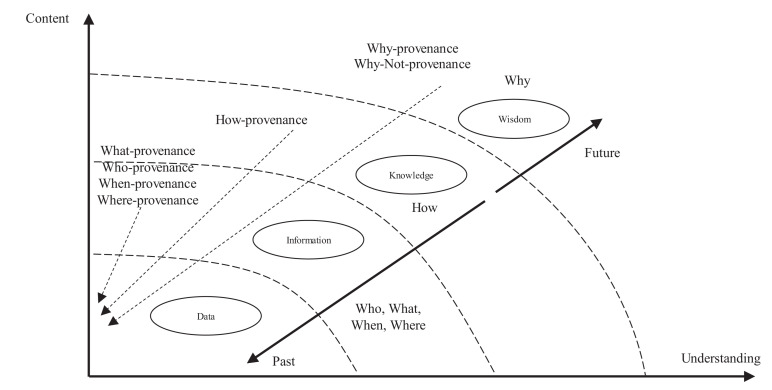
The DIKW provenance.